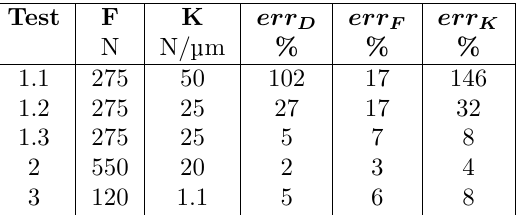
Table 3: Approximated measurement error with differ- ent combination of measurement devices. In percents of the measured stiffness.